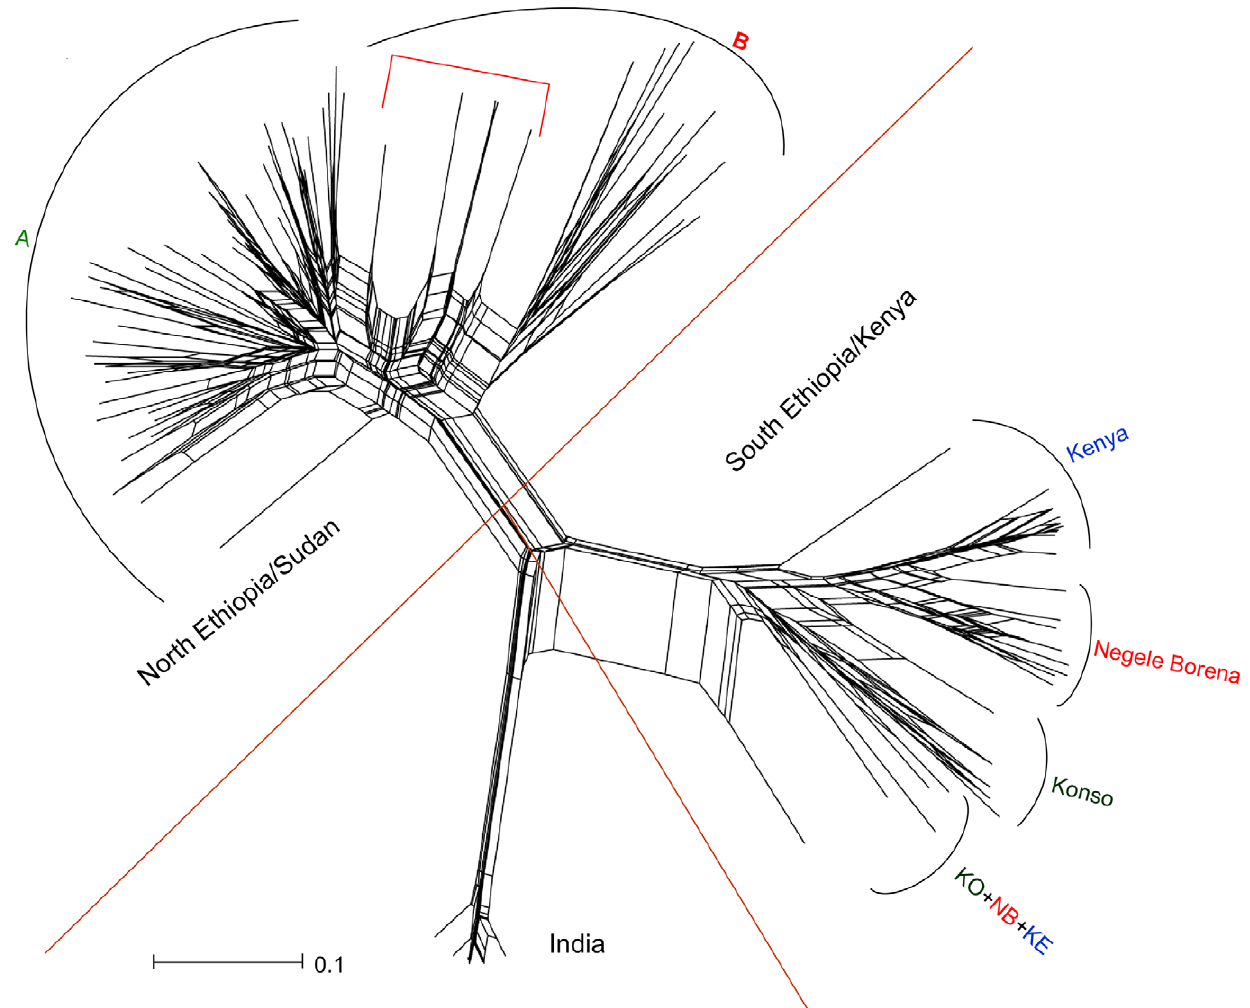
Figure 3. Phylogenetic network (unrooted) for 123 L.donovani strains constructed with the Neighbor-Net algorithm. STRUCTURE, NJ tree and network analyses detected the same three main populations as well as the two subpopulations (A and B) in the North Ethiopia/Sudan population and the four clusters; Konso, Negele Borena, Kenya and KO + KE + NB; in the South Ethiopia/Kenya population. The reticulate patterns seen in the network indicates either hybridization or recombination events between similar or closely related genotypes. The putative hybrid genotypes are indicated by a red bar line on the top. They are located in between their hypothetical parental strains in NE/SD-A subpopulation A and in cluster B1 of the NE/SD subpopulation B.